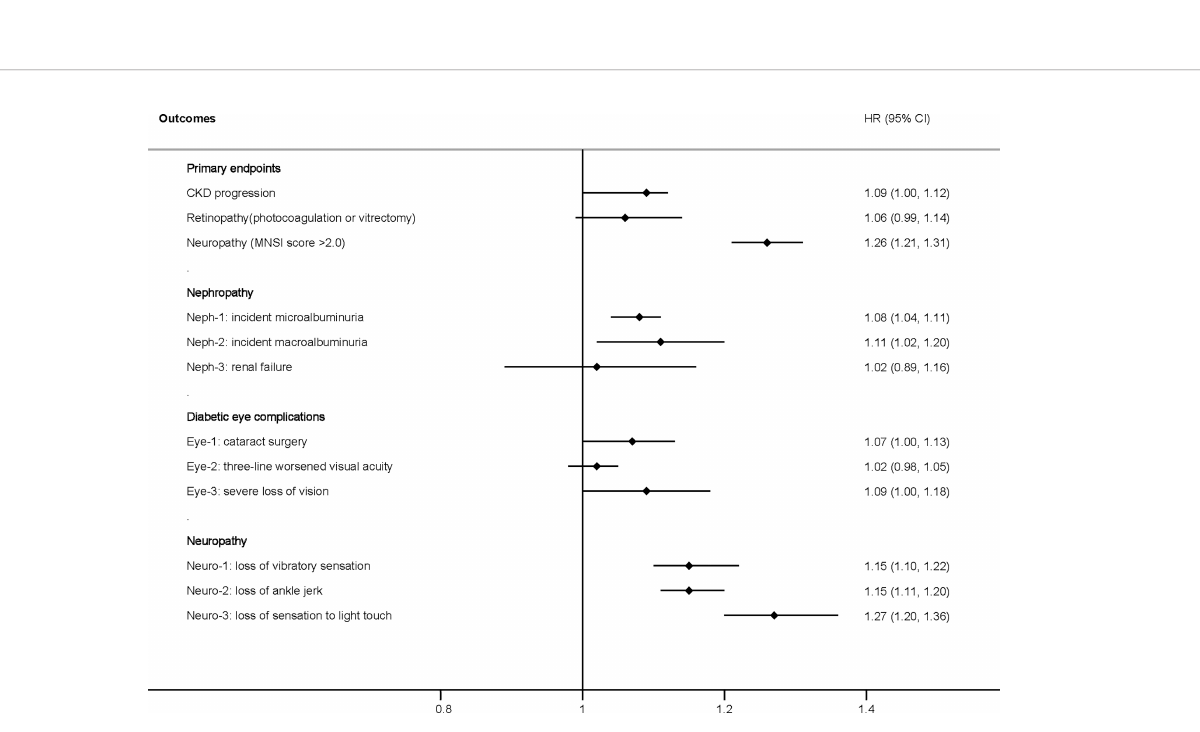
FIGURE 1 | Hazard ratio per one standard deviation increase in the FMI for the primary and secondary endpoints. Adjusted for model 3, including age, race, sex, treatment effect, duration of diabetes, proteinuria, current smoking, weekly alcohol consumption, height, glomerular fi ltration rate, total cholesterol, low-density lipoprotein cholesterol, high-density lipoprotein cholesterol, systolic blood pressure, and hemoglobin A1C. CKD, chronic kidney disease; HR, hazard ratio; FMI, fat mass index; MNSI, Michigan Neuropathy Screening